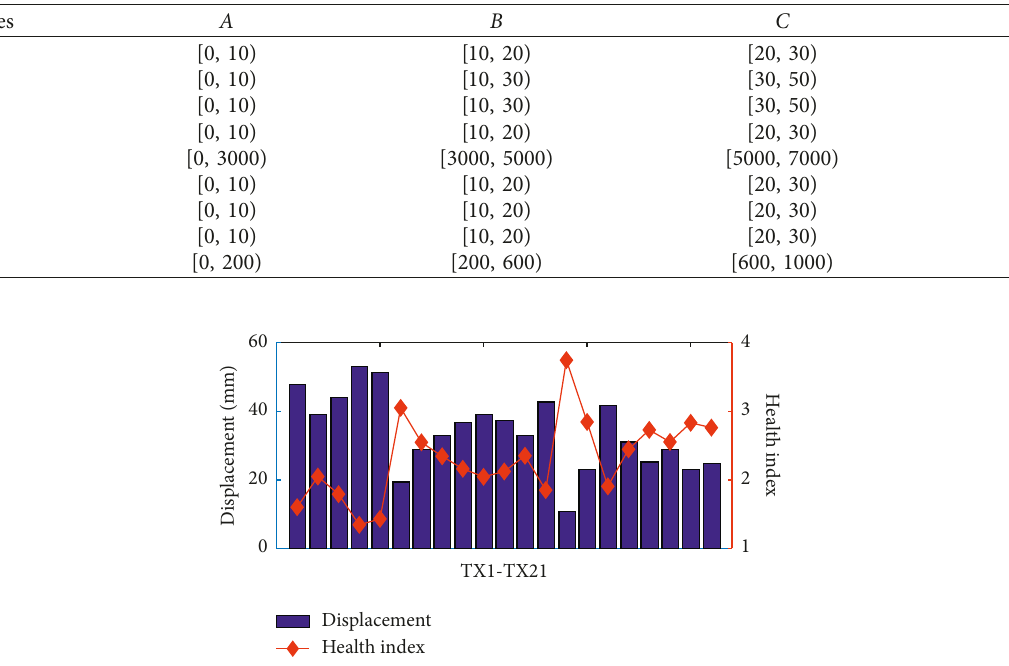
Table 4: Health ranges division of monitoring factors.